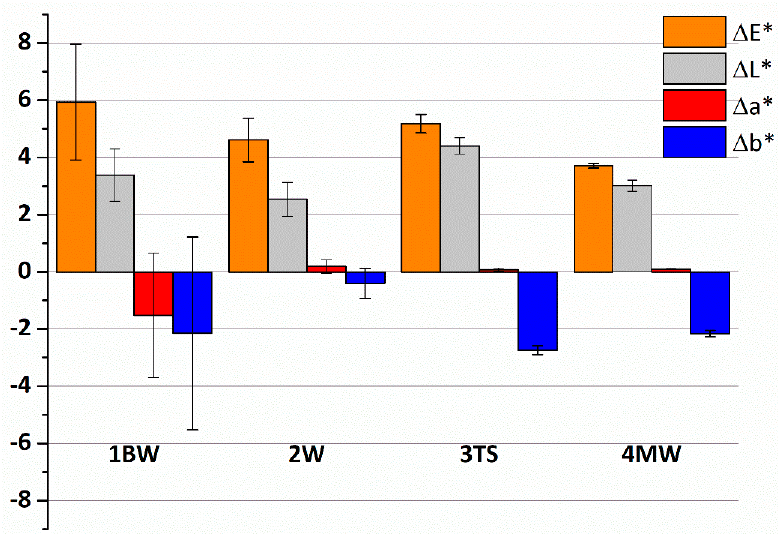
Figure 8. Colorimetric variation before and after the coating application expressed as ∆ E *, ∆ L *, ∆ a * and ∆ b *.